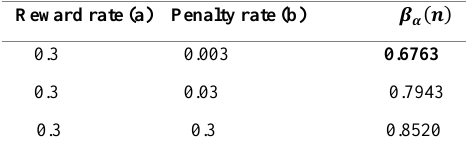
Figure 17. Relationship between the number of rules and different minimum supports. Table 10. Change of to increase b .